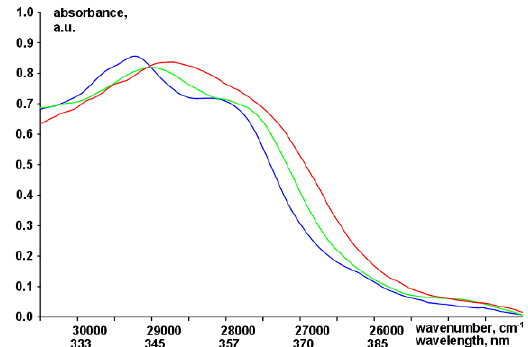
Figure 7. Absorption spectra of bis-flavonol in octane (blue), toluene (green) and ethanol (red); see colors in the online version of this